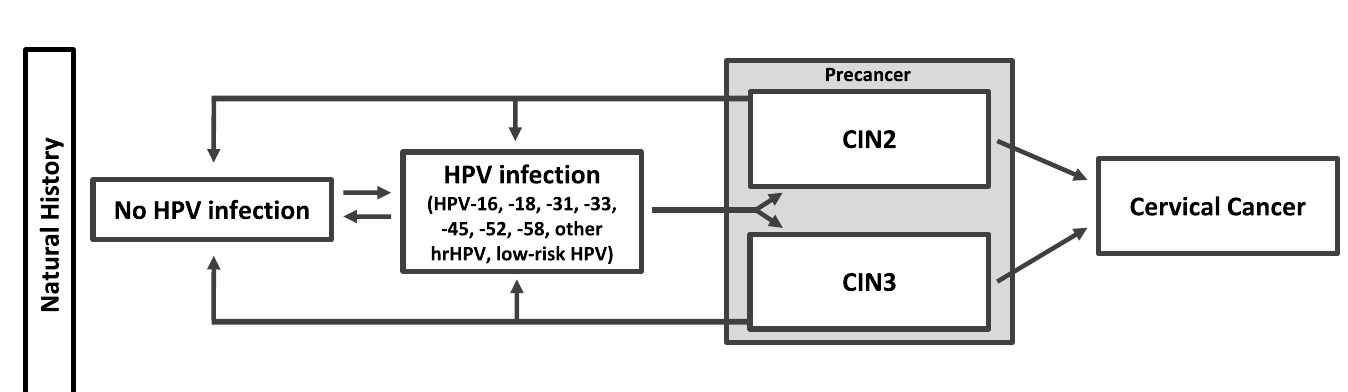
Fig 1. Model schematic for the progression of human papillomavirus (HPV) infection to cervical cancer. HPV infections and pre-cancer (cervical intraepithelial neoplasia (CIN), grade 2 (CIN2) or grade 3 (CIN3)) were stratified by genotype (HPV types 16, 18, 31, 33, 45, 52, and 58; other oncogenic types; and non-oncogenic types). Precancerous health states (CIN2 and CIN3) were considered as heterogeneous entities with differential probabilities of regression and progression to cancer. Progression to cancer required infection with an oncogenic type. Cancer could be symptom-detected at either the local stage, the regional stage, or the distant stage. Women are at risk of dying from background mortality in any